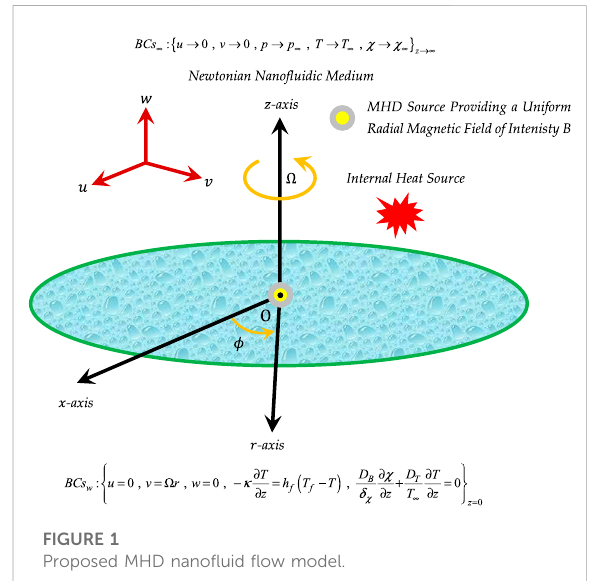
FIGURE 1 Proposed MHD nano fl uid fl ow